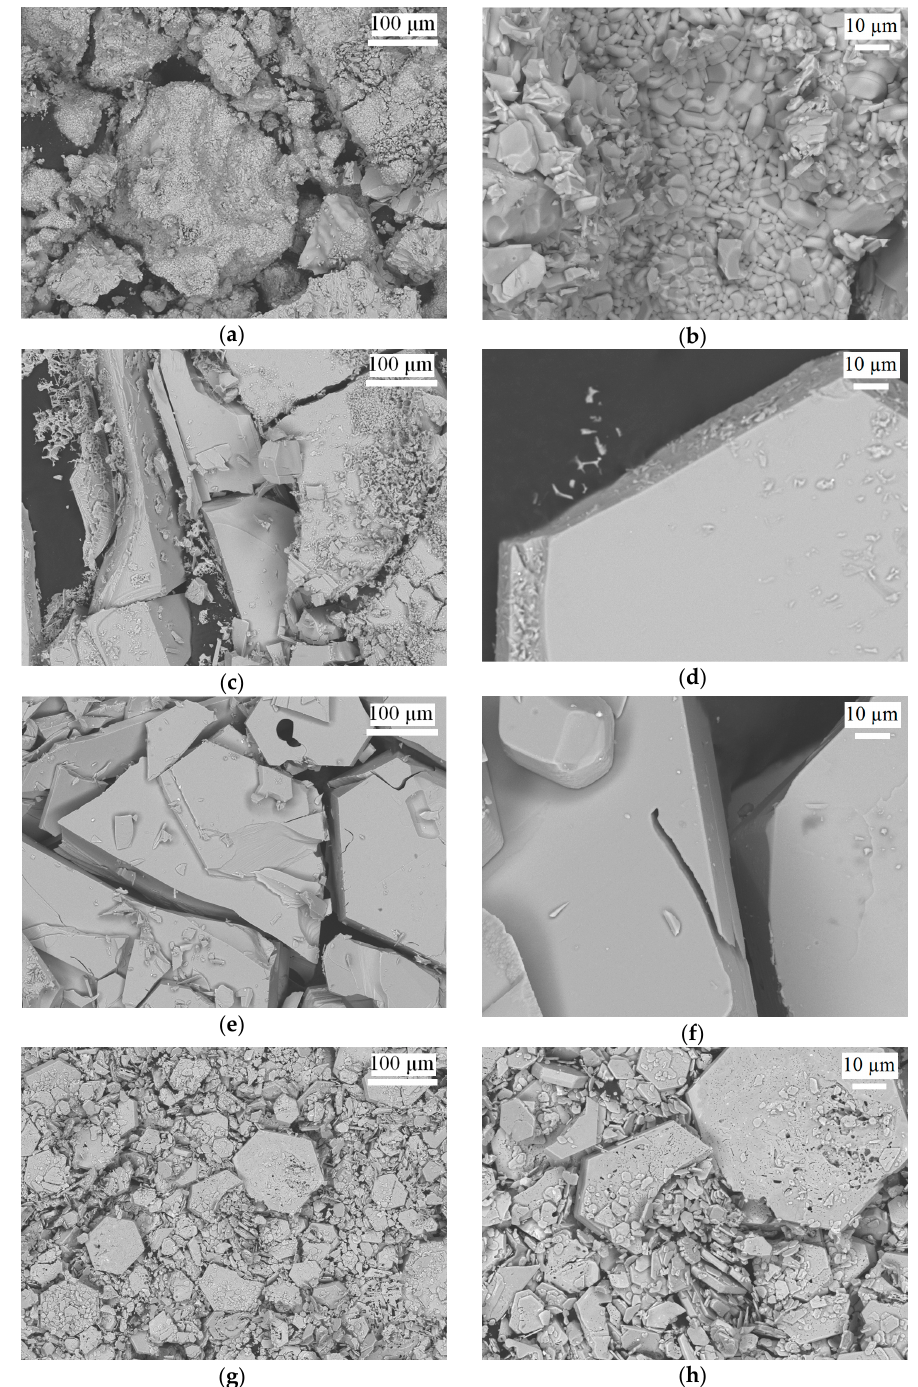
Figure 1. SEM images of barium hexaferrite samples from: ( a , b ) solid-state sintering; ( c , d ) Na 2 CO 3 flux; ( e , f ) BaB 2 O 4 flux; ( g , h ) 60 at % PbO flux (see Table 1).